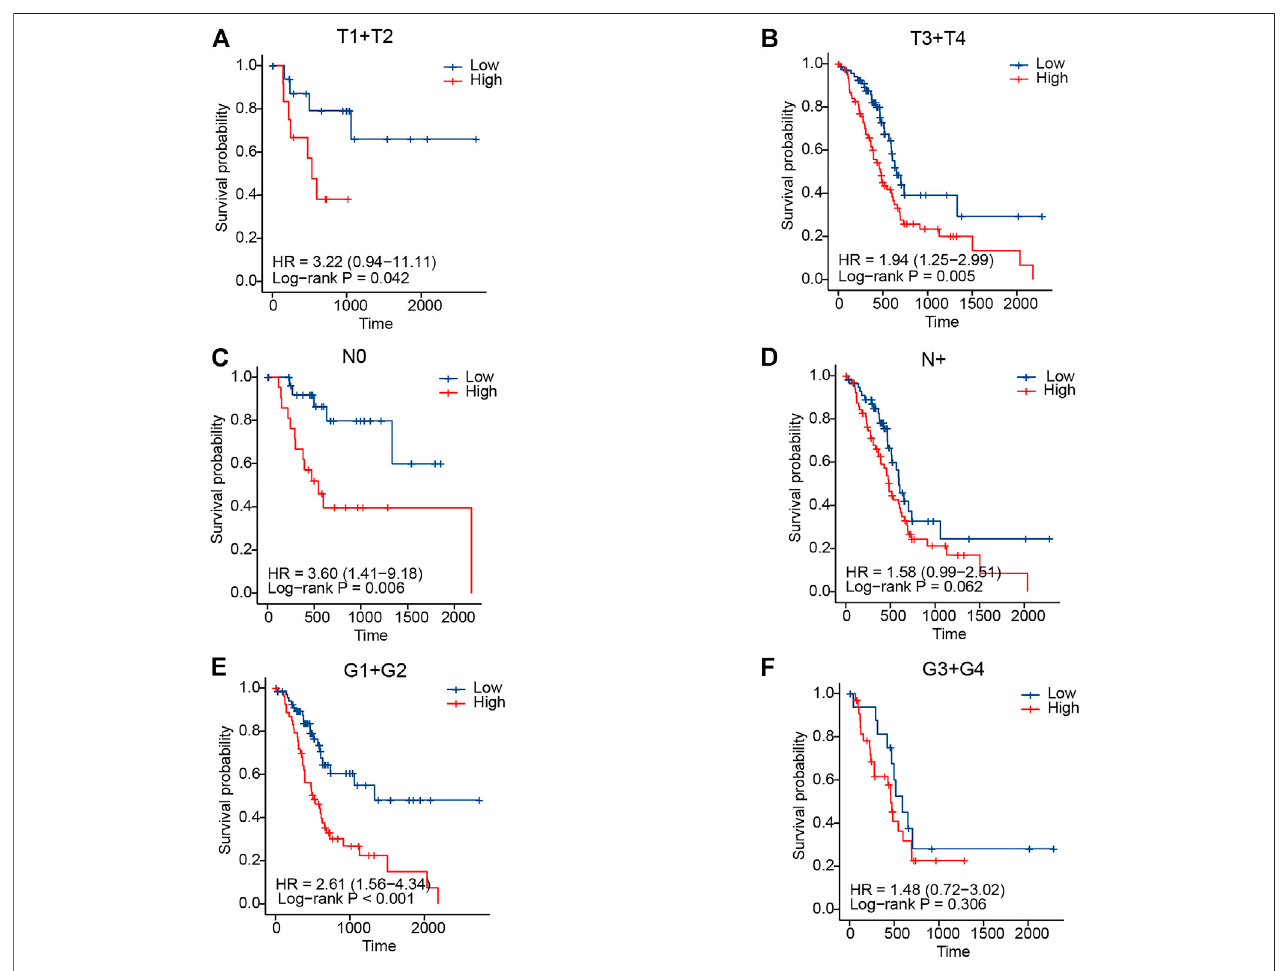
FIGURE 4 | Association between the signature and clinical parameters in TCGA cohort. (A,B) KM curves for T-staging subgroups in high- and low-risk patients, respectively. (C,D) KM curves for lymph node metastasis status subgroups in high- and low-risk patients, respectively. (E,F) KM curves for tumor grade subgroups in high- and low-risk patients,